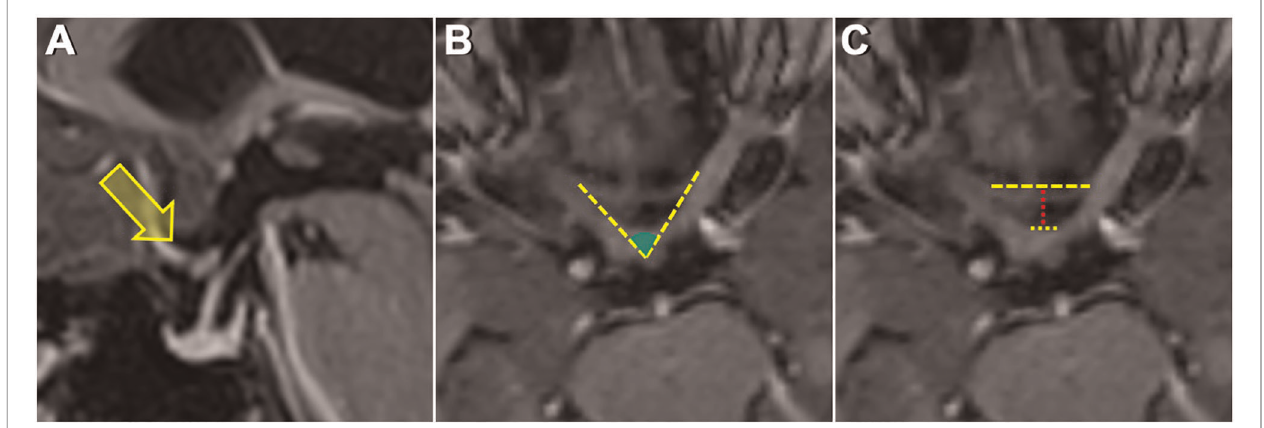
FIGURE 1 | ( A ) Sagittal MRI image showing a pre fi xed chiasm — overlying tuberculum sella. ( B ) Measurement of the interneural angle on axial reformatted images along the intracranial optic nerves. ( C ) Upper dashed yellow line shows the distance between the bilateral optic nerves at the entrance to the optic canal. The lower dashed yellow line shows the distance between the optic nerves just before they form the optic chiasm. The dashed red line shows the distance from the anterior aspect of the optic chiasm to the limbus sphenoidale.